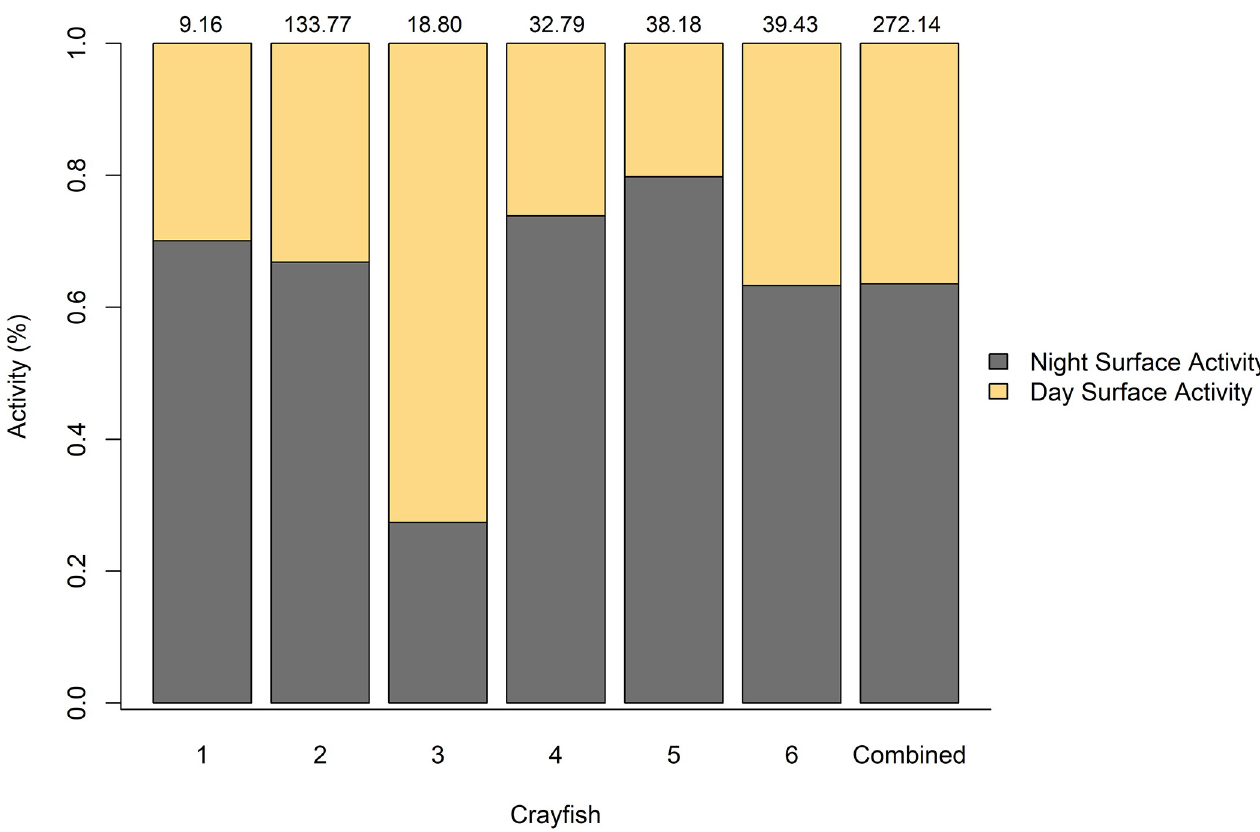
Fig 6. The percentage of time that Lacunicambarus thomai was observed exhibiting surface activity during the day and during the night. We report the percentage of time that each individual crayfish spent during the day and the night as a combined total for all six crayfish. For each crayfish, the total number of time (hours) that each crayfish was filmed active is listed above the